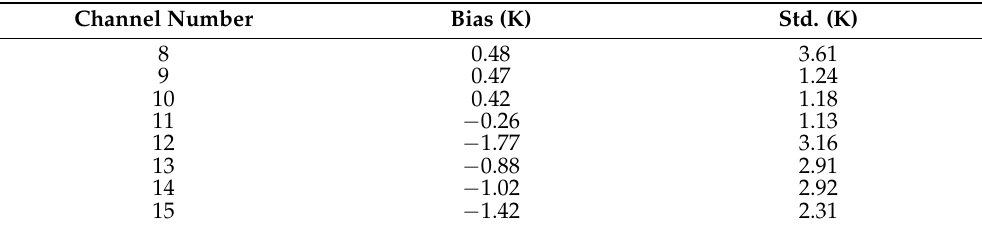
Table 4. Biases and standard deviations of Fengyun-4B/AGRI IR channels brightness temperature observations and RTTOV simulations over land under clear-sky conditions and with satellite zenith angles less than 60° from June to November 2022.